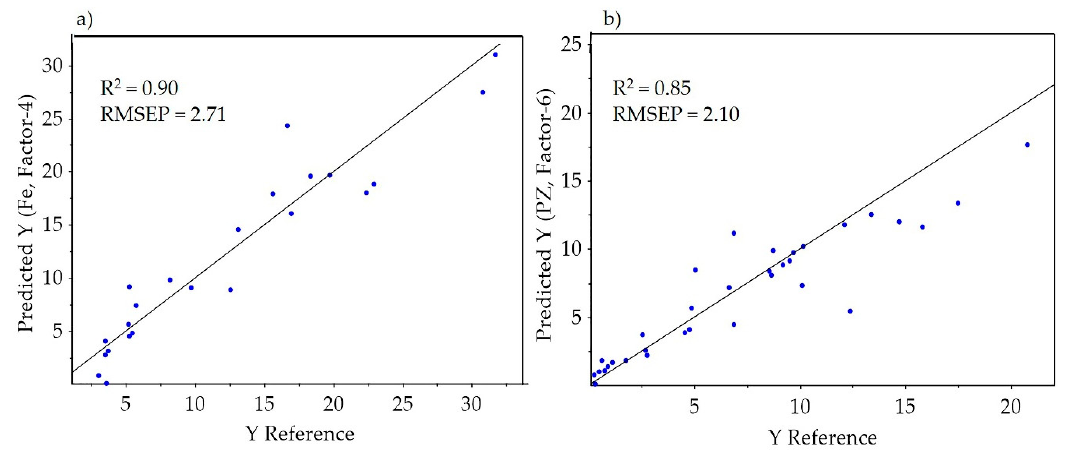
Figure 6. Predicted versus actual ( a ) Fe concentration values (wt.%); ( b ) the combined Pb–Zn concentration values (wt.%) computed using a low-level data fusion approach.